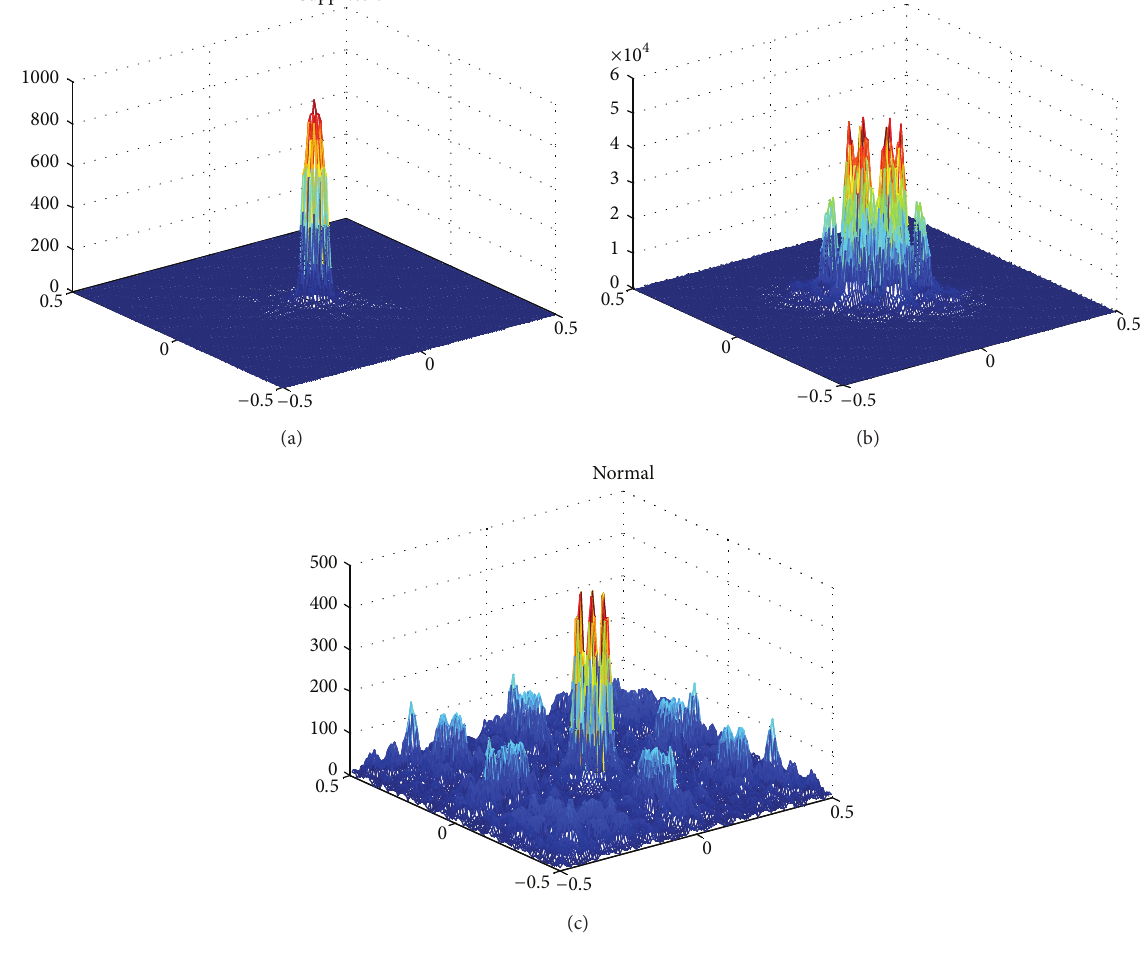
Figure 7: The bispectrum of burst, suppression, and normal states, respectively.